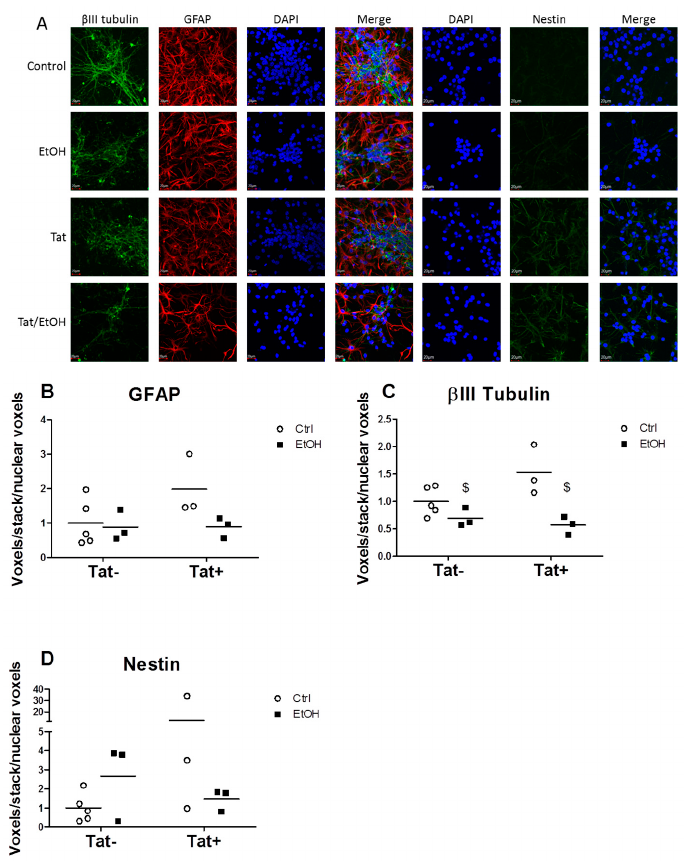
Figure 4. Panel ( A ) shows representative images from embryonic mouse neural progenitor cells (NPCs) treated with ethanol (EtOH) and/or trans-activator of transcription (Tat) on day one of proliferation and during four days of differentiation. Control staining is shown in the first row, EtOH in the second row, Tat in the third row, and Tat/EtOH in the fourth row. Quantification of immunofluorescence for each marker ( β III tubulin for neurons, glial fibrillary acidic protein (GFAP) for astrocytes, and nestin for neural progenitors) is shown in panels ( B – D ). Each symbol represents one experimental well. N = 5 for the control group and n = 3 for the experimental groups. Bar indicates the mean of each group. $ indicates main effect of alcohol ( p < 0.05) by two-way